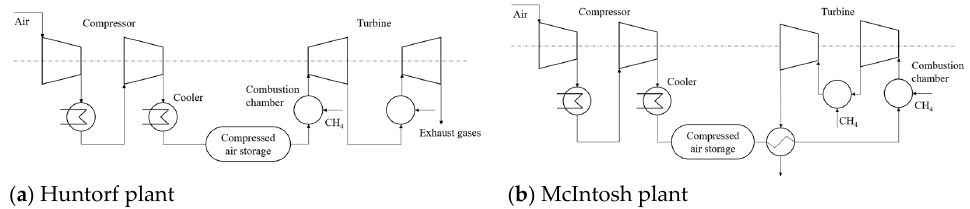
Figure 19. Compressed air energy storage systems: ( a ) Huntorf plant, Germany; ( b ) McIntosh plant, Alabama, USA.